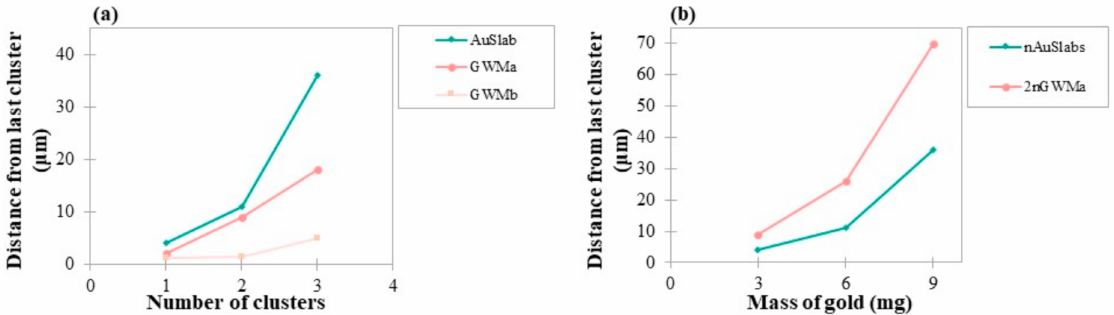
Figure 8. ( a ) Distance from AuNPs clusters where DEF remains ≥ 1.04 as a function of clusters number. AuSlab, GWMa and GWMb have densities of 19.3 g/cm 3 , 18.43 g/cm 3 and 13.4 g/cm 3 and contain 3, 1.5 and 0.3 mg of gold, respectively; ( b ) Distance from AuNPs clusters where DEF remains ≥ 1.04 as a function of the mass of gold. Results are depicted for n = 1, 2 and 3 where n is the number of AuSlabs. The corresponding mass of gold embedded in the water phantom for n = 1, 2 and 3 is equal to 3 mg, 6 mg and 9 mg, respectively. Points are connected with lines for illustration